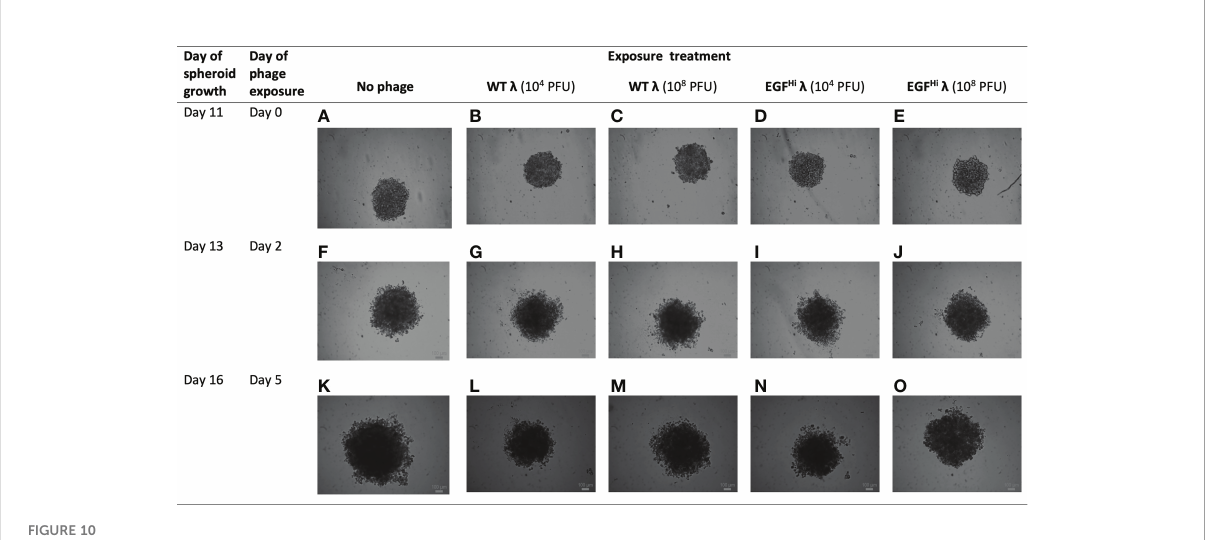
FIGURE 10 Addition of l phages to fully-formed HT-29 spheroids does not impede tumor expansion. WT l (B, C, G, H, L, M) and EGF Hi l (D, E, I, J, N, O) phages at two doses (10 4 or 10 8 PFU) were added to fully-formed but small dimension HT-29 spheroids at day 11 after seeding. Spheroid development was imaged for a further 5 d. with a bright- fi eld microscope, showing the full-thickness spheroids and compared to controls (A, F, K) . Representative photographs from one series in 3 independent experiments. Scale bar: 100 m